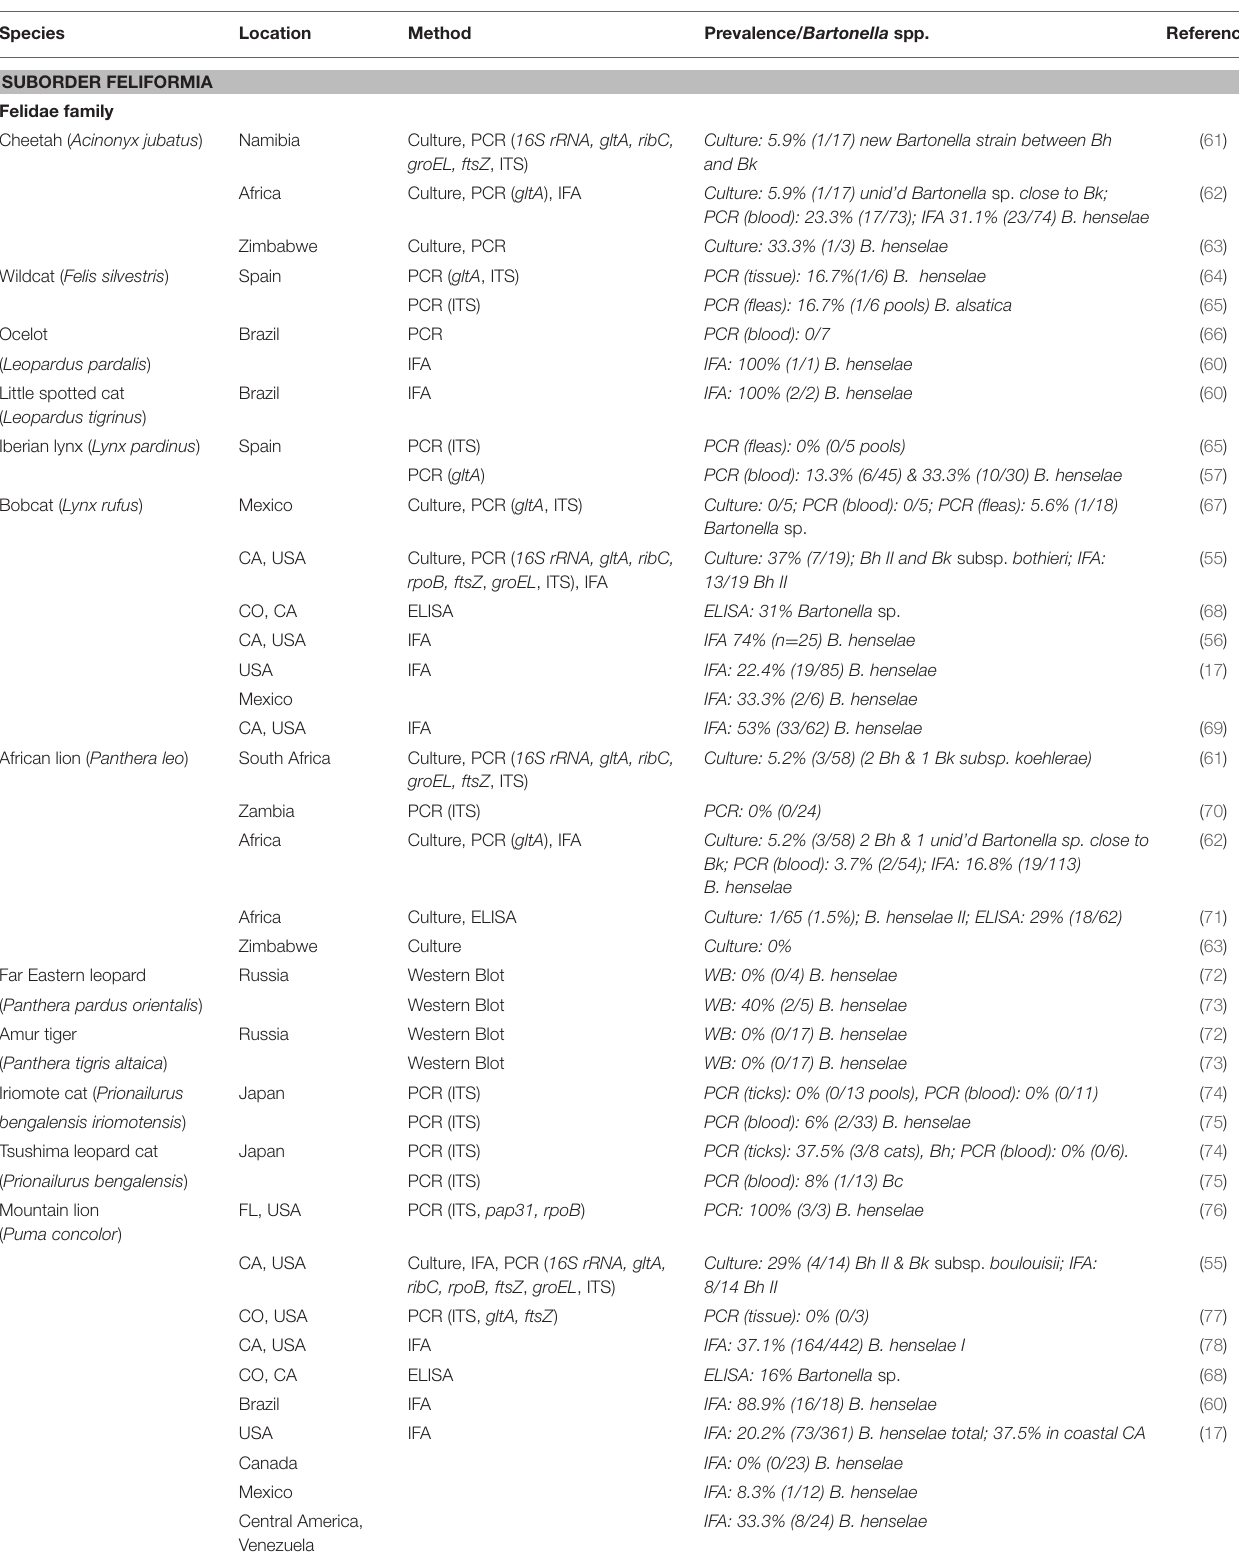
TABLE 1 | Bartonella studies in wild carnivores by